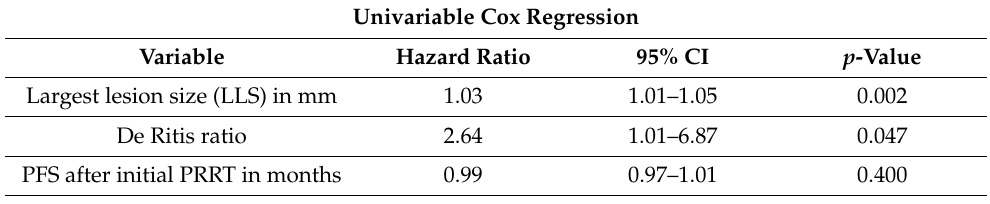
Table 2. Univariable and multivariable Cox regression for PFS. All variables were included as continuous variables.